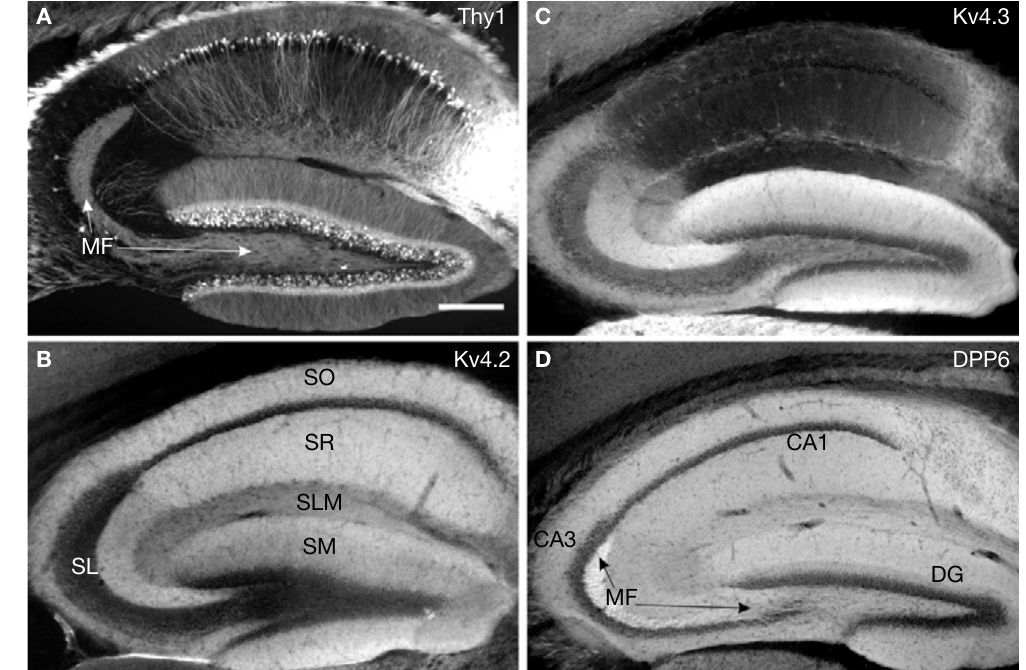
Figure 5 | Immunolocalization of Kv4 and DPP6 in the mouse hippocampus. (B–D) Immunofl uorescent staining for Kv4.2, Kv4.3 and DPP6 is concentrated in dendritic fi elds, including the apical and basal dendrites of CA pyramidal cells and the apical dendritic fi elds of the granule cells in the dentate gyrus (DG). The somata and dendrites of GABAergic interneurons are stained with Kv4.3, but not with Kv4.2 or DPP6 antibodies. The mossy fi bers (MF) are labeled with antibodies to DPP6, but not with antibodies to Kv4.2 or Kv4.3. (A) As reference, the hippocampus of a Thy1-H YFP mouse (Feng et al., 2000) expressing YFP in a subset of pyramidal cells in the CA1–CA3 fi elds and granule cells of the DG is shown. Note the labeled cell bodies and dendrites of pyramidal and granule cells. The axons of the granule cells (MF) are also YFP labeled. Scale bar: 200 μ m. SO, stratum oriens; SR, stratum radiatum; SM, stratum moleculare; SL, stratum lucidum; SLM, stratum lacunosum moleculare.